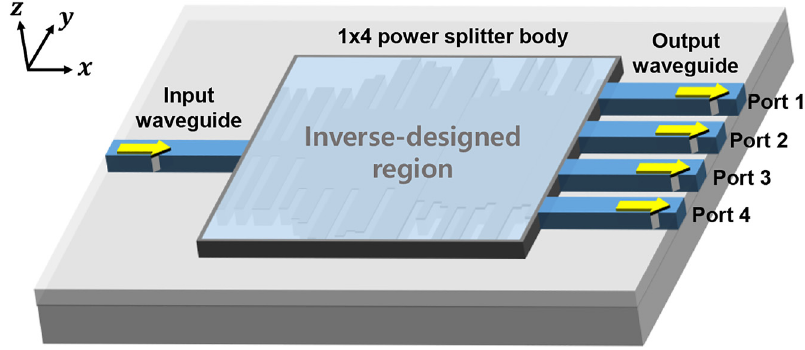
Figure 1: Schematic of the inverse-designed 1 × 4 optical power splitter on an SOI